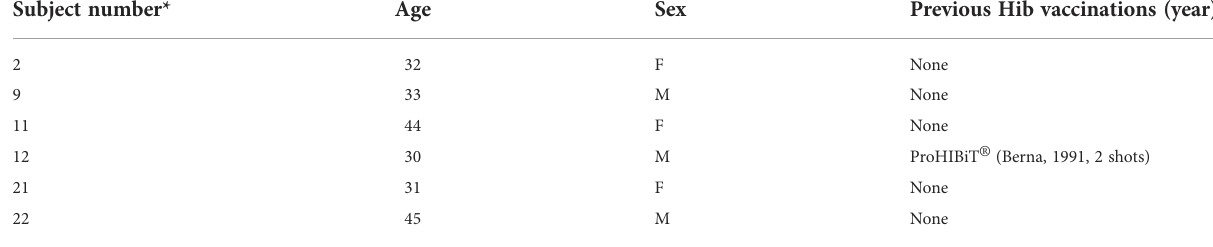
TABLE 1 Study subjects and their vaccination status prior to study